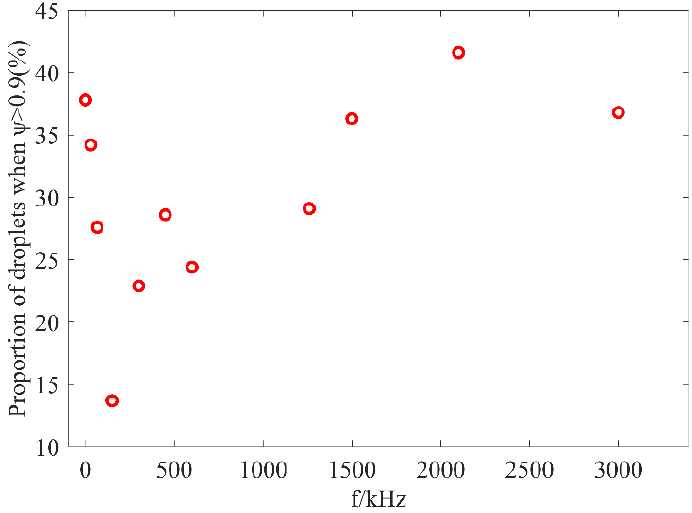
Figure 13. Proportion of droplets with sphericity above 0.9.